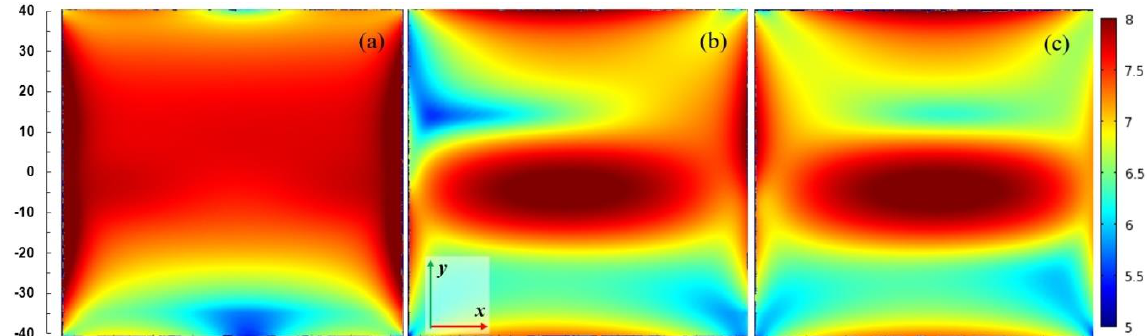
Figure 9. Spatial distributions of the log 10 of Q rh /(1 Wm −3 ) in the x - y plane passing through the center of the plasma for P ent = 100 W. ( a ) L = 15 mm, ( b ) L = 25 mm, and ( c ) L = 35 mm. The scale on the left shows dimensions in mm.